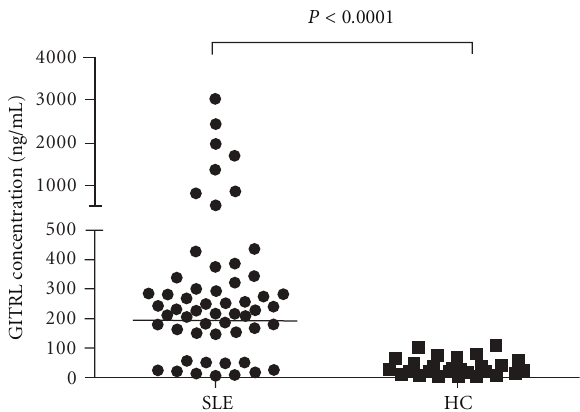
Figure 1: Comparison of serum GITRL levels between SLE and HC. Serum GITRL levels were significantly elevated in SLE patients versus HC. Each symbol represents an individual patient and healthy donor. Horizontal lines indicate median values. HC: healthy control; SLE: systemic lupus erythematosus.